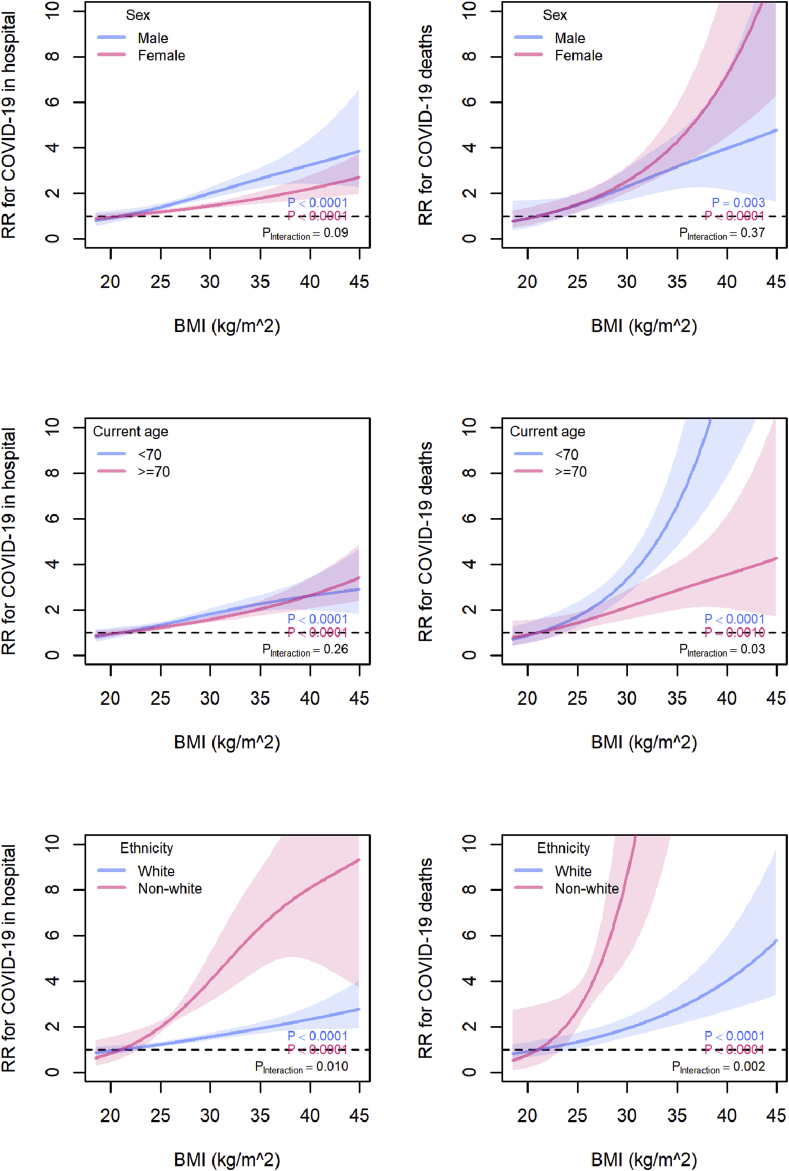
Associations of BMI with COVID-19 confirmed in hospital and COVID-19 deaths by sex (panels a to b), by age (panel c–d) and by ethnicity (panel e–f).